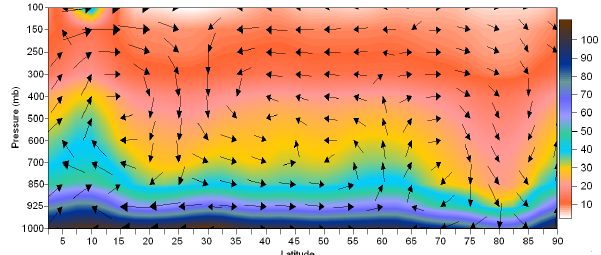
Fig. 3. Vertical profile of computed α -HCH air concentration using Eq. (6), superimposed with vector winds of v and w component shown in Fig. 2. In the presentation of the vector winds, the vertical velocity w is multiplied by 100.